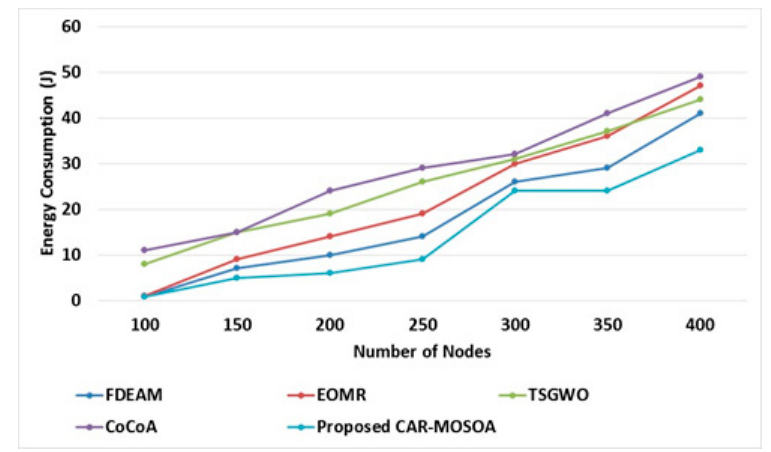
Figure 4. Performance based on energy consumption. Table 2. Comparative analysis of energy consumption.